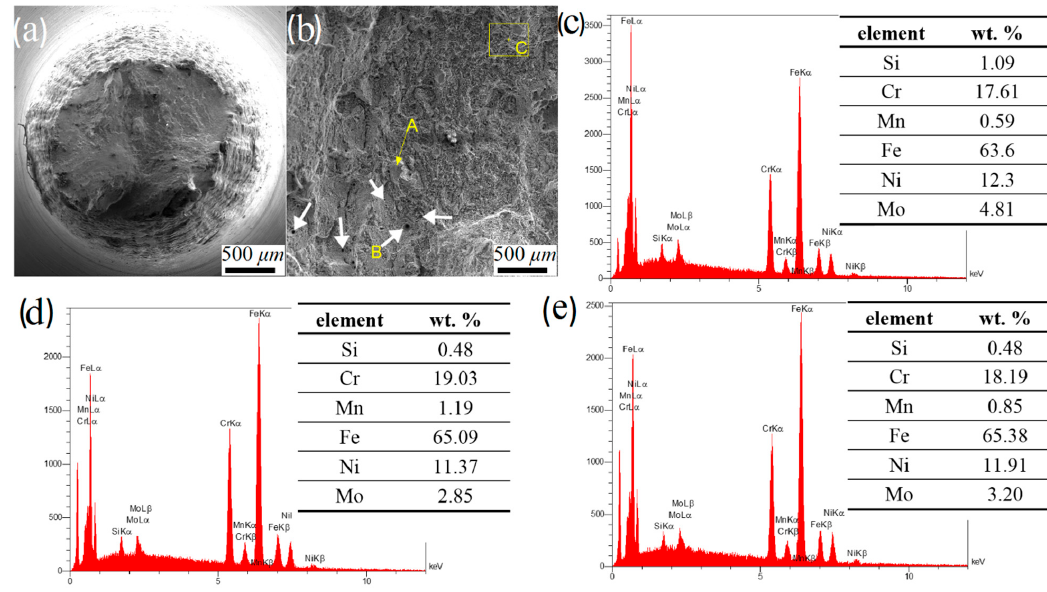
Figure 5. SEM images of the fractured surfaces of UC-1.2 sample: ( a ) low magnification, ( b ) high magnification, and ( c – e ) EDS analysis of the points A, B, and C, respectively, in ( b ). White arrows refer to the porosities. EDS peaks are X-rays given off as electrons return to the K electron shell (K-alpha (K α ) and K-beta (K β ) lines).